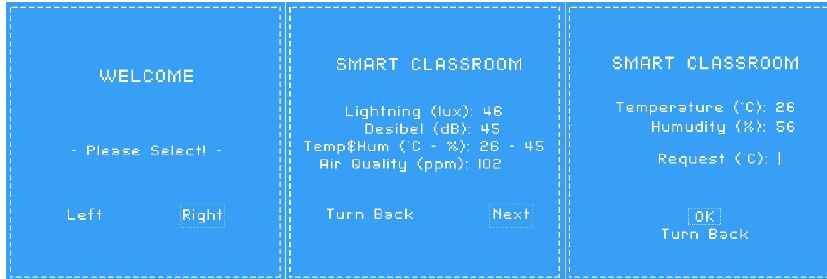
Figure 6. Data box interface .